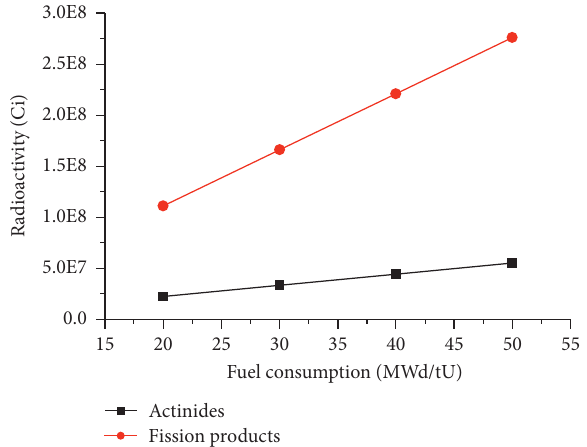
Figure 5: The radioactivity of actinides and fission products at different specific powers.